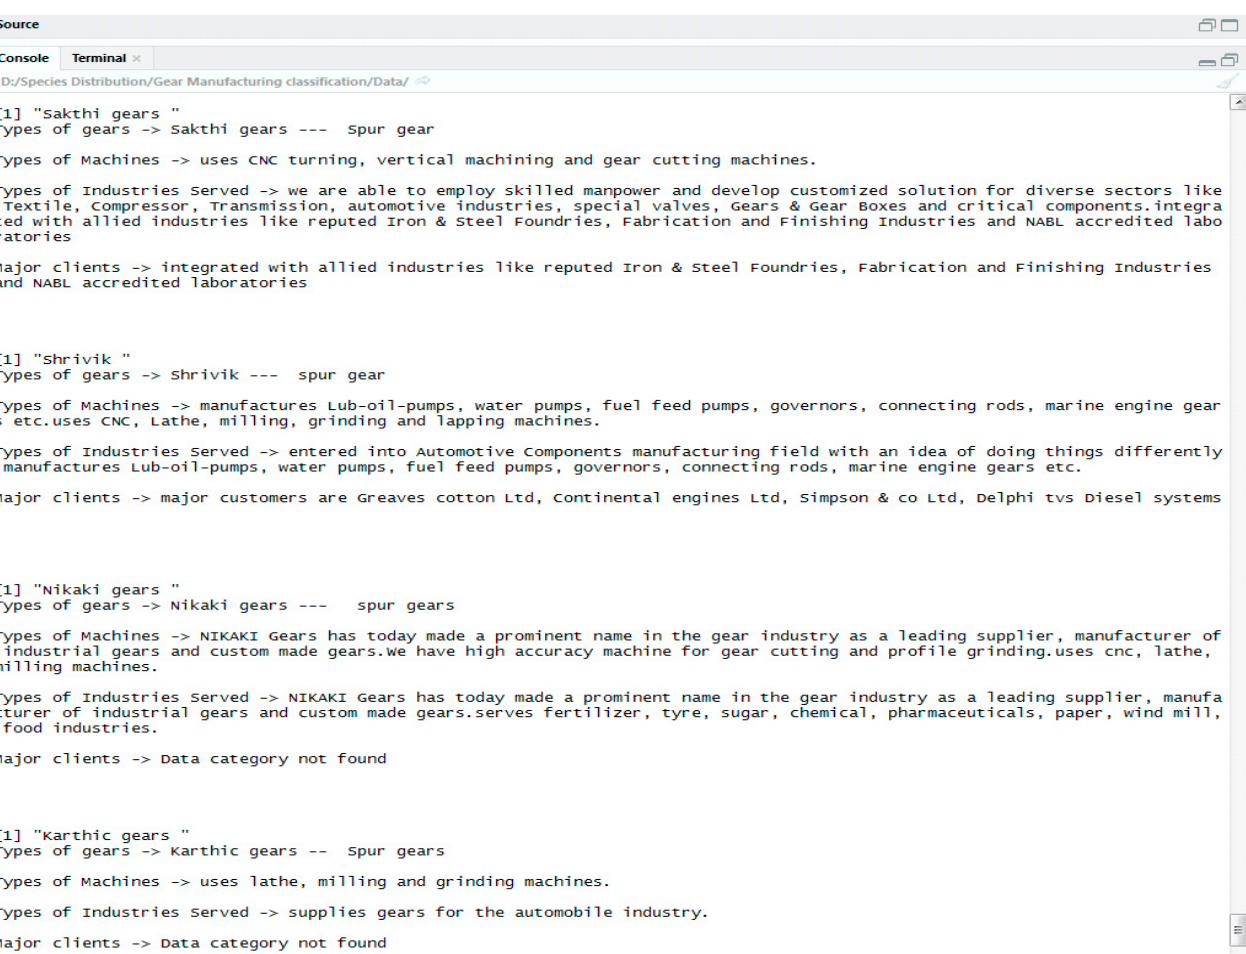
Figure 5. Confusion matrices of Naïve Bayes, Random Forest, SVM, and Decision Trees.